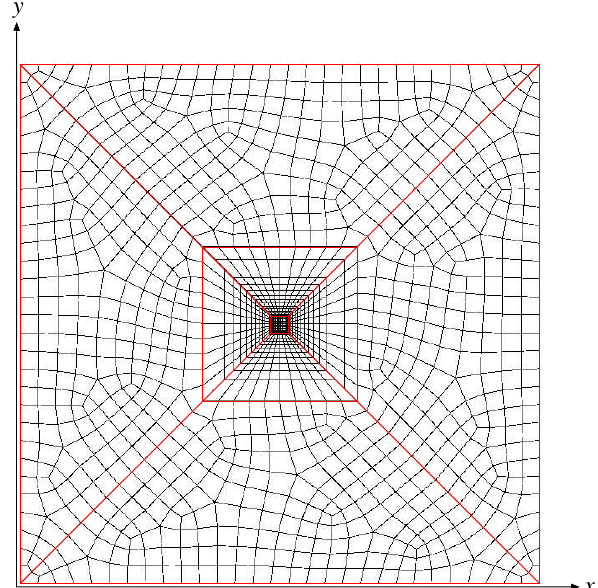
Fig. 5. Plan view of the finite element mesh of the 203 . 092 × 203 . 092 km model domain (created with the pre-processing soft- ware Gambit). The inner 6 × 6km and 60 × 60km domains defined for creating the mesh (see main text) are marked as red